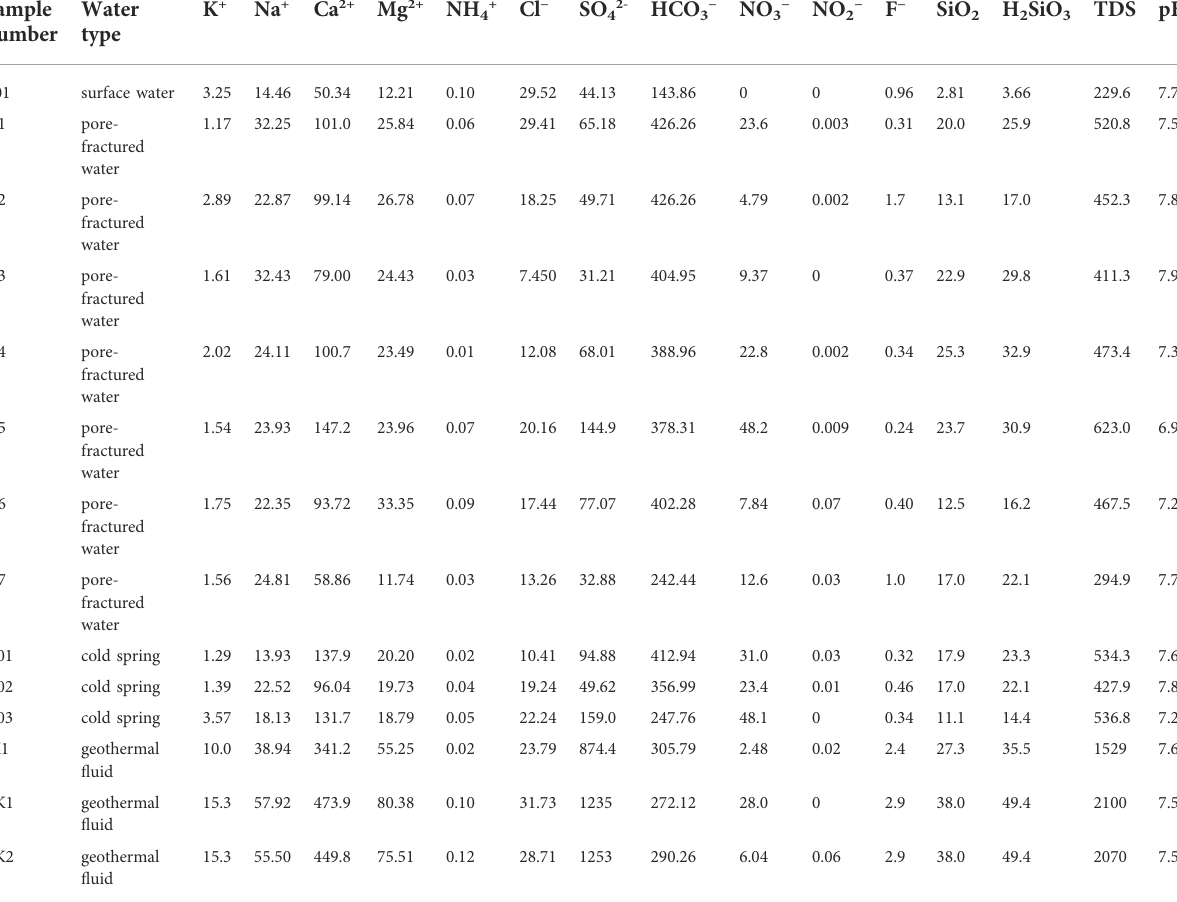
TABLE 2 Chemical composition analysis experiment data (Unit: